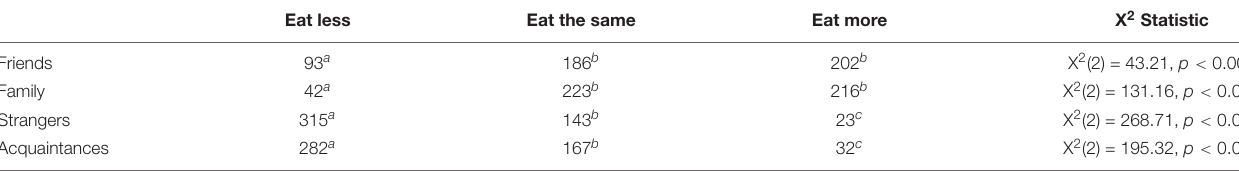
TABLE 2 | Response frequency ( n ) for each scenario Study 1. Eat less Eat the same Eat more